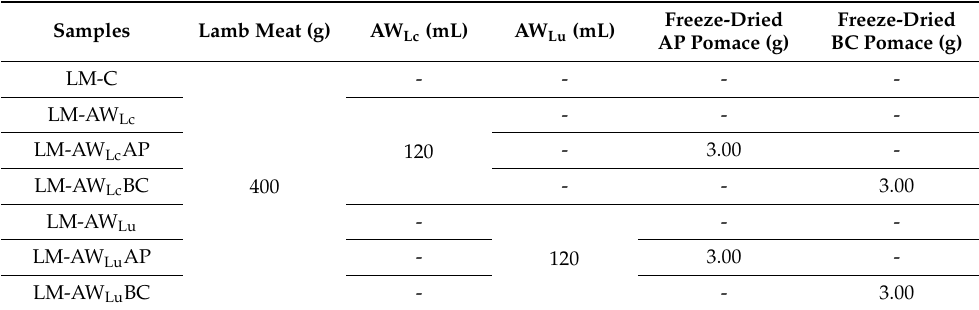
Table 2. The lamb meat treatment